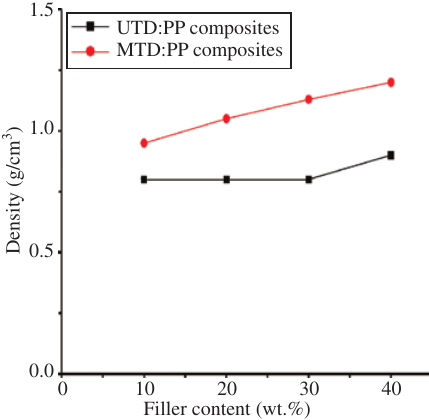
Figure 8: Density of TD:PP